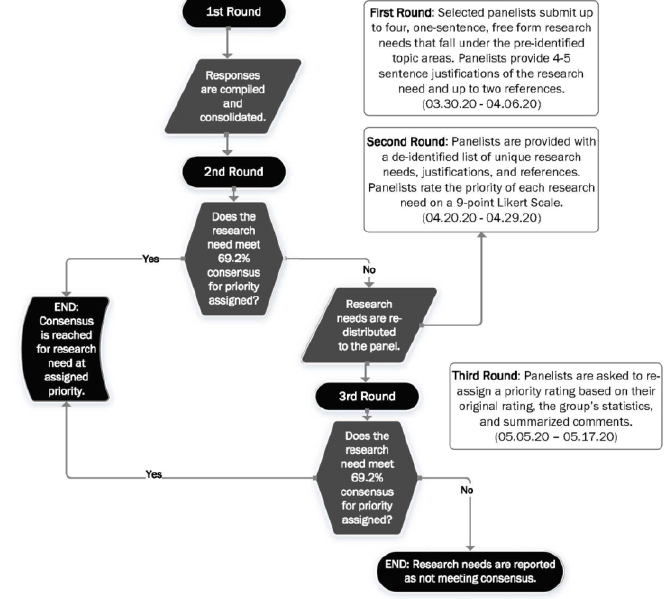
Figure 1. Process Figure 1. Process Overview.